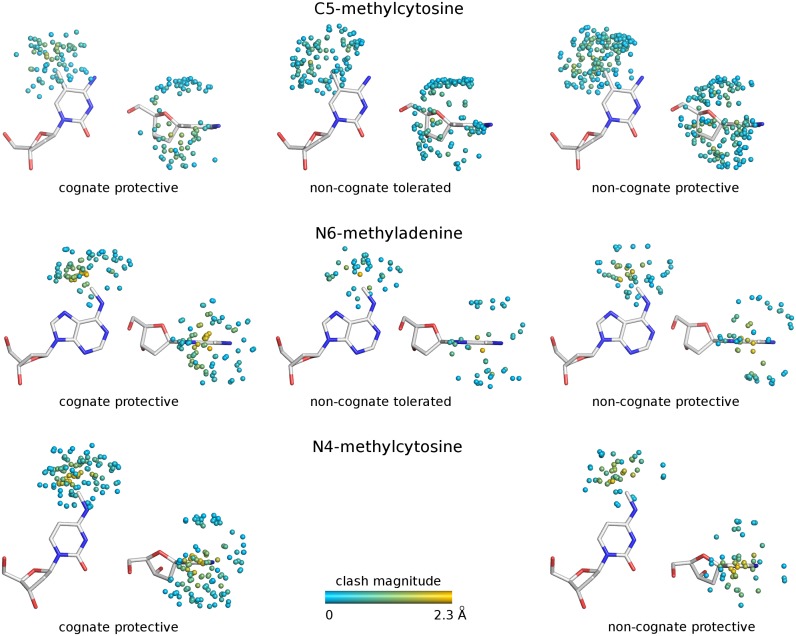
Spatial distribution of atoms potentially clashing with the methyl groups. Only the atoms for which the distance to the methyl group is below the sum of the van der Waals radii (allowing 0.1 Å for coordinate uncertainty) are shown and colored according to the severity of the steric conflict. Only one molecule in the asymmetric unit was chosen. The clashes of the methyl groups on both DNA strands are included.